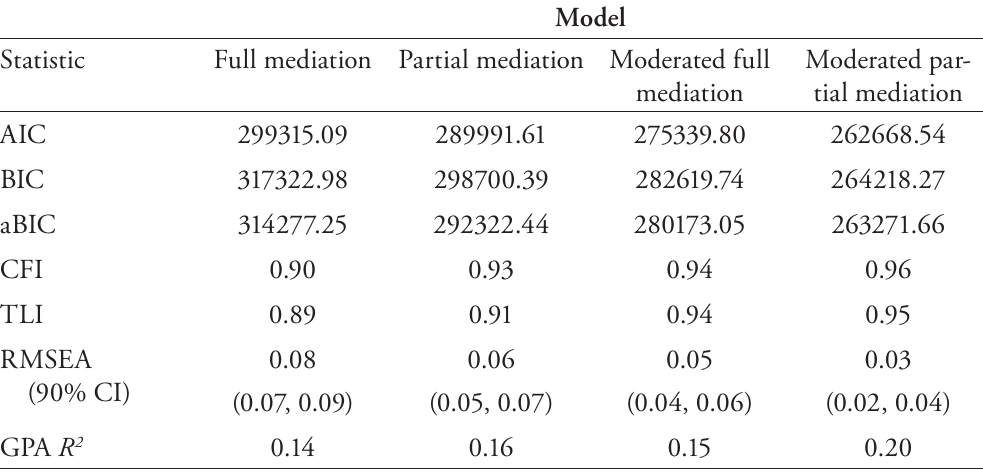
Table 2. Model Fit